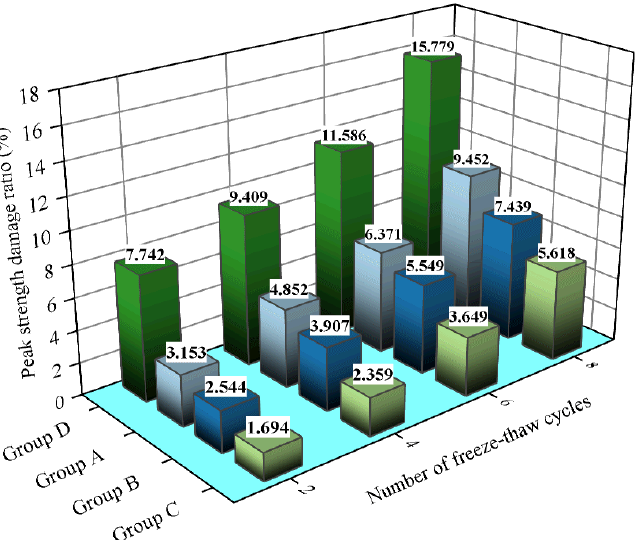
Figure 11. Relationship between the number of freeze-thaw cycles and the peak strength damage rate.